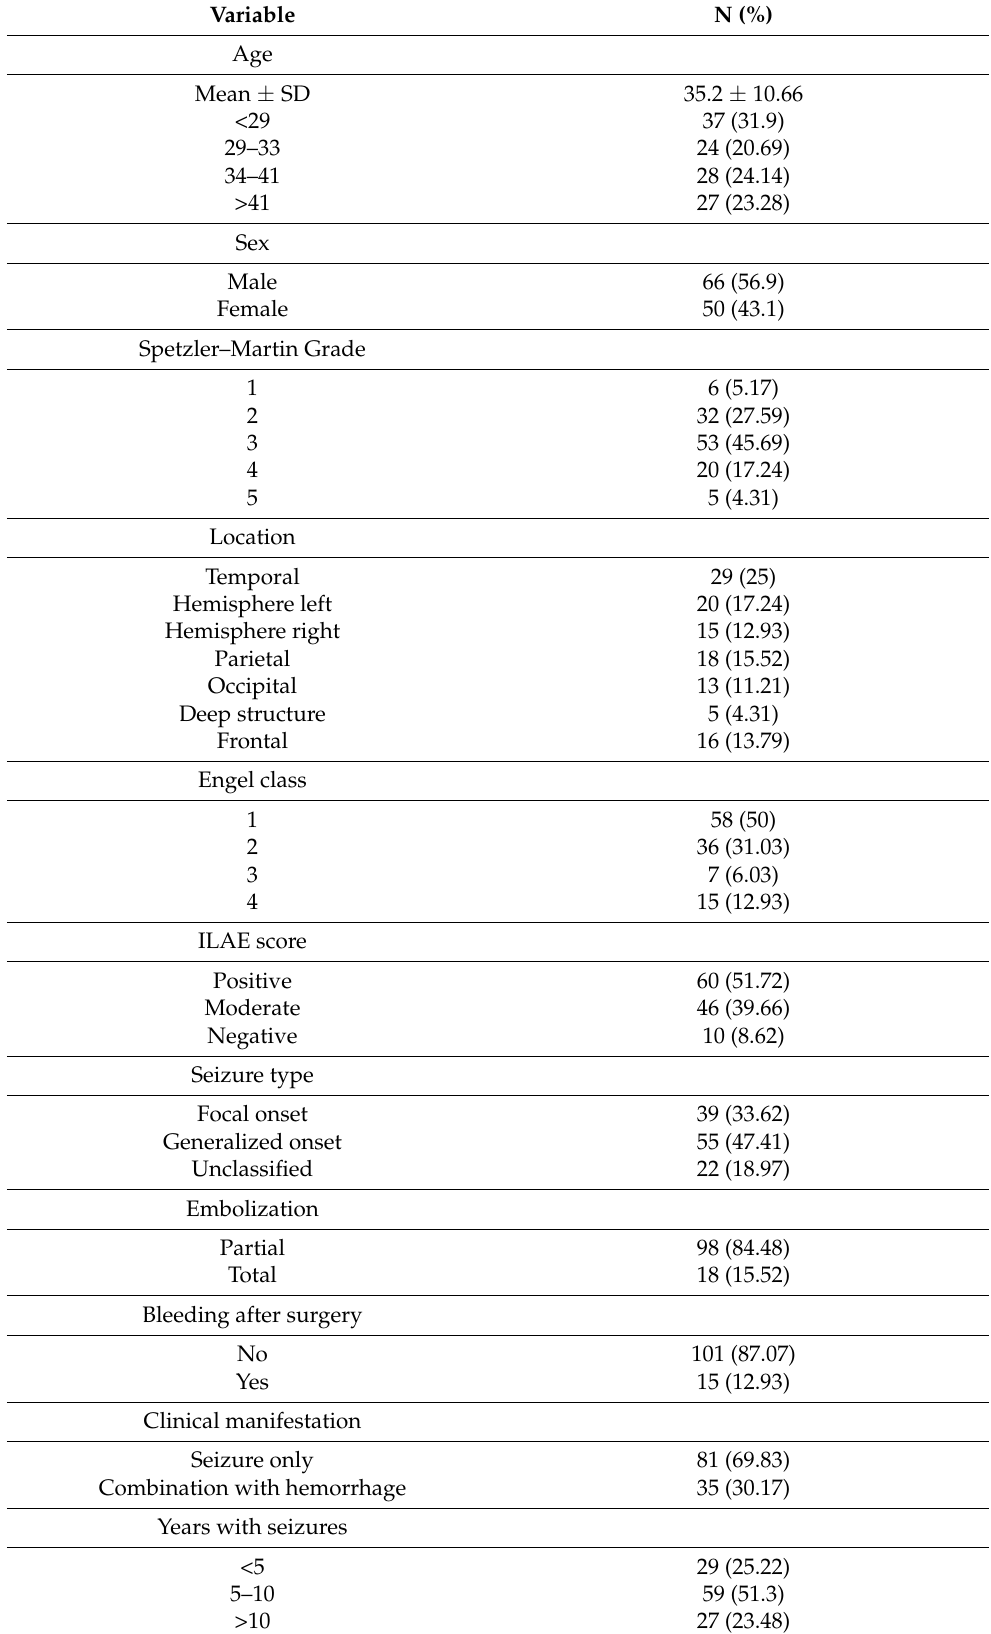
Table 1. Demographic and clinical characteristics of